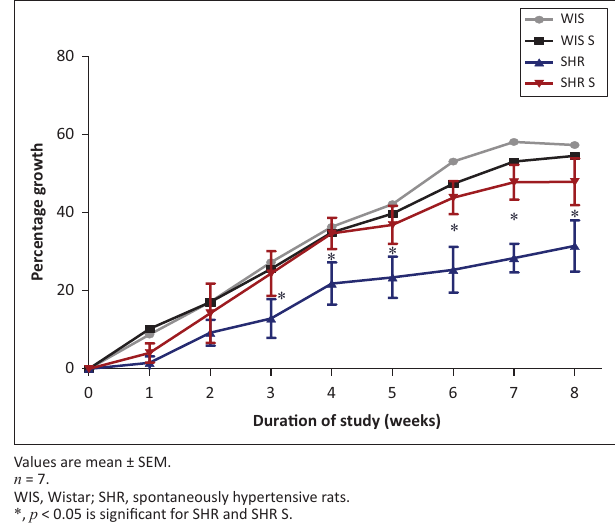
FIGURE 1: The effect of multivitamin-multimineral supplementation on growth rate in spontaneously hypertensive and Wistar